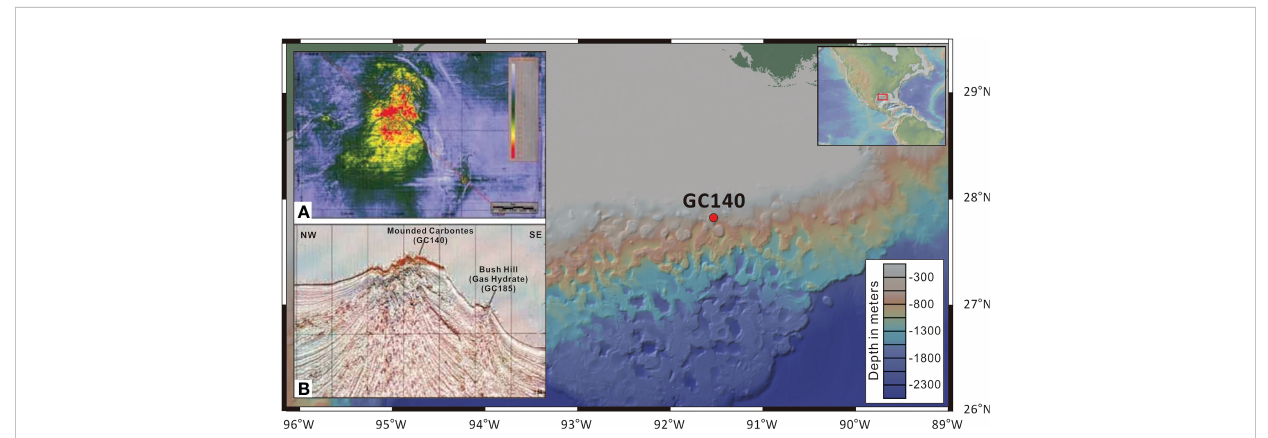
FIGURE 1 Location of the Green Canyon block 140 (GC140; 27°48 ′ N/91°32 ′ W) study site, northern Gulf of Mexico (from Bian et al., 2013). The inset 3-D seismic surface amplitude illustrates the extent of the hard bottom (A) and the pro fi le view (B) , showing that the dome top has an irregular surface and that the sea fl oor re fl ector is a strong, positive re fl ector, indicating a hard bottom (Roberts,